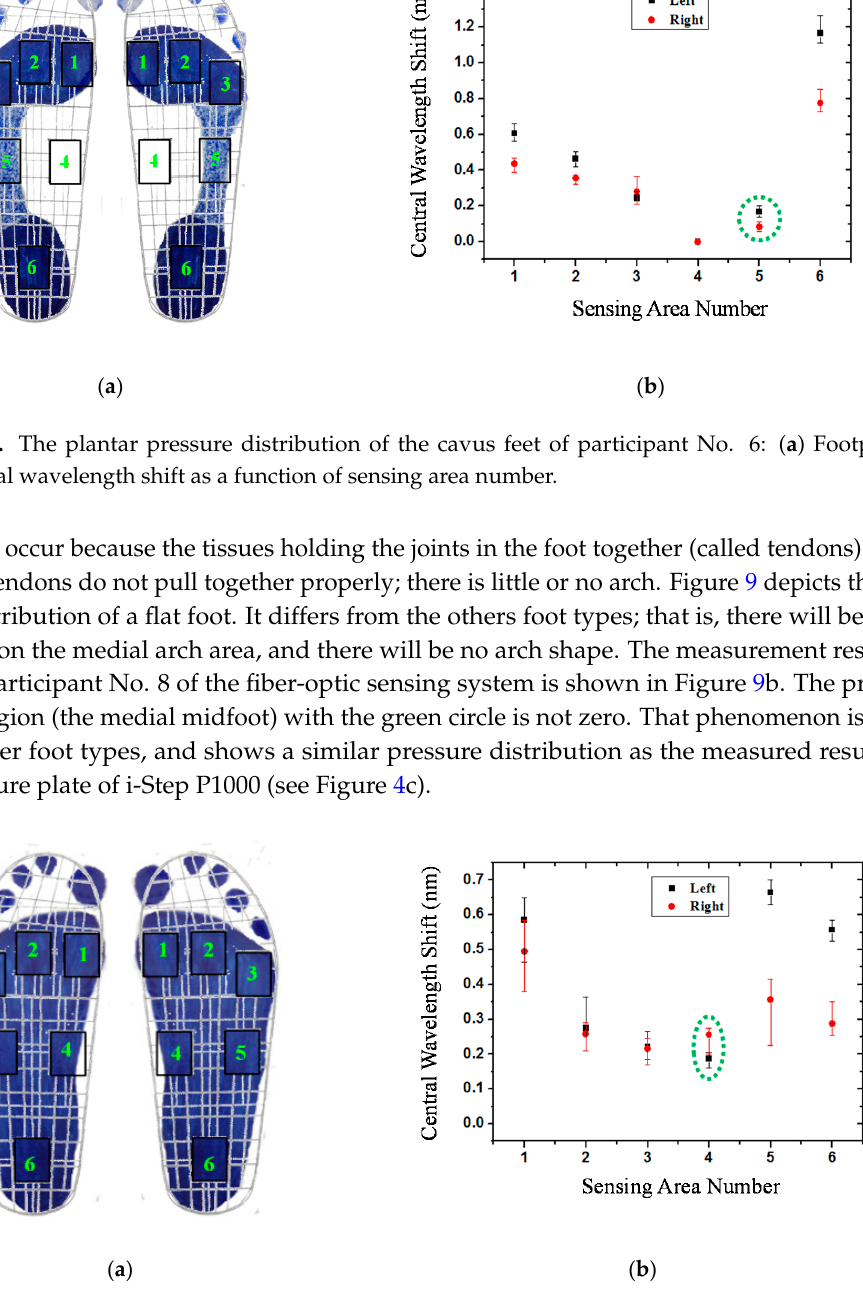
Figure 9. The plantar pressure distribution of the flat feet of participant No. 8: ( a ) Footprint; ( b ) central wavelength shift as a function of sensing area number.